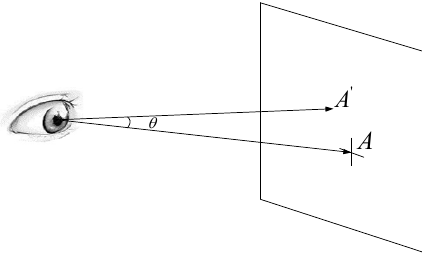
Figure 9. Definition of gaze estimation accuracy.